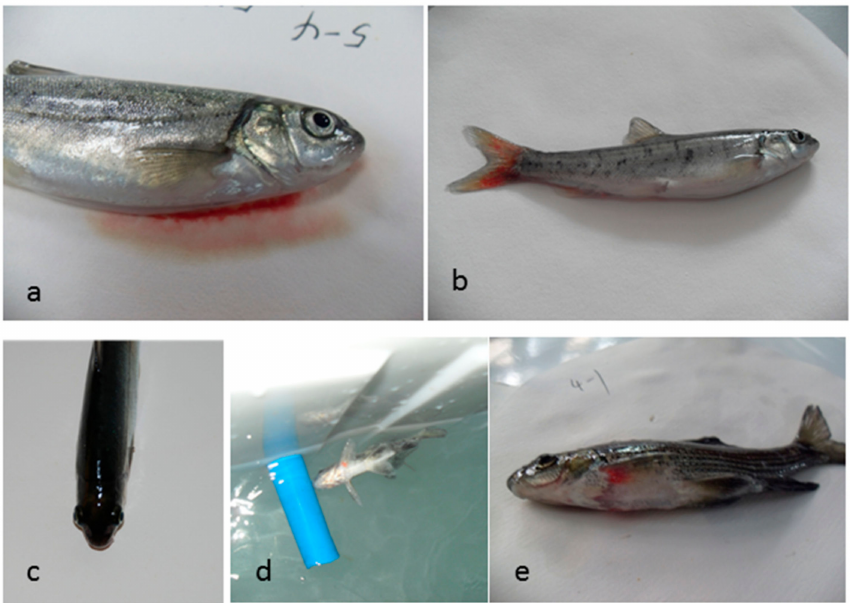
Figure 1. Typical signs of the experimental fish after removal from the total dissolved gas (TDG)-supersaturated water, including ( a ) gill bleeding, ( b ) caudal fin bleeding, ( c ) exophthalmos, ( d ) spiral swimming, and ( e ) body